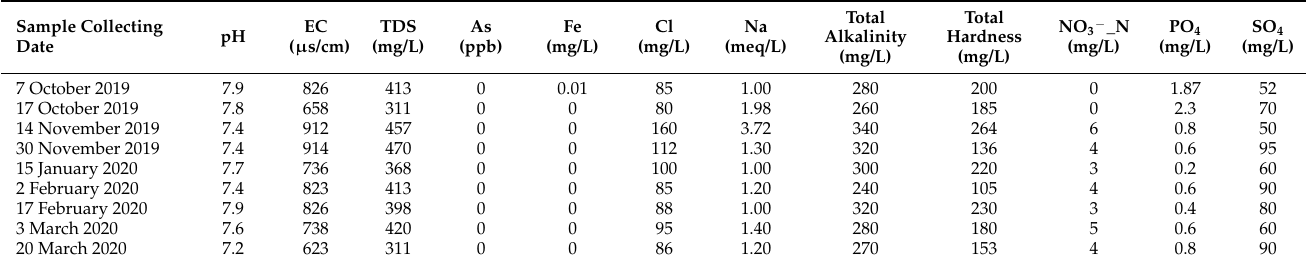
Table 1. Irrigation water quality of grey and rainwater mix.